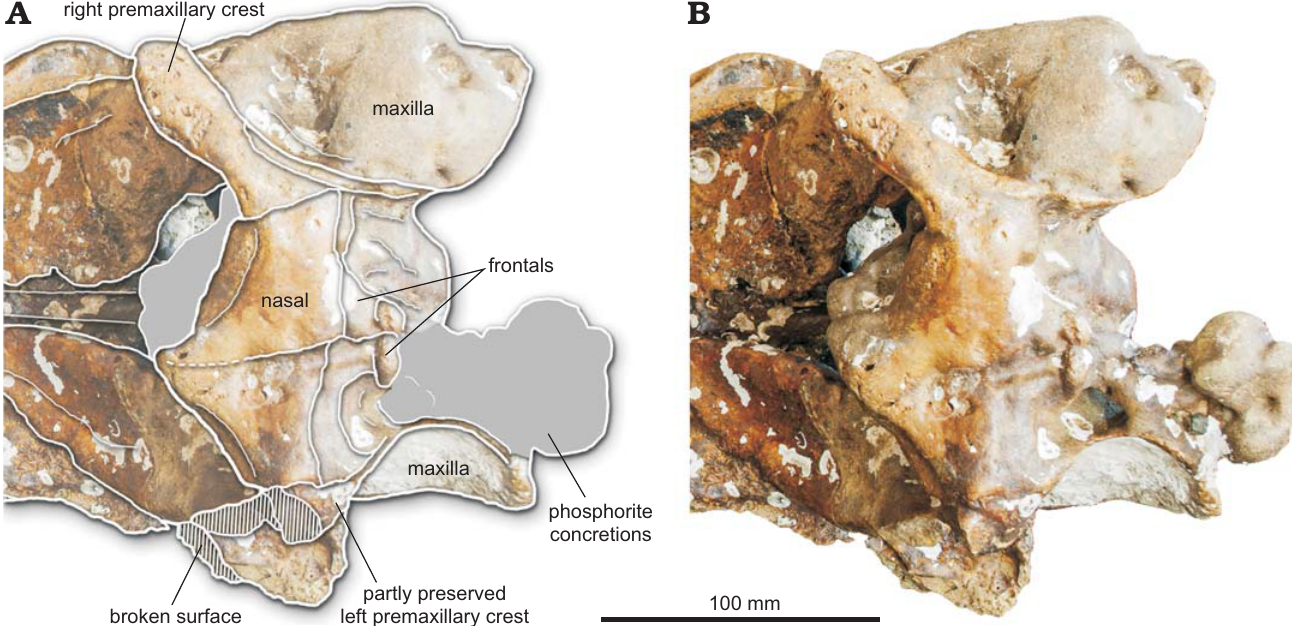
right premaxillary